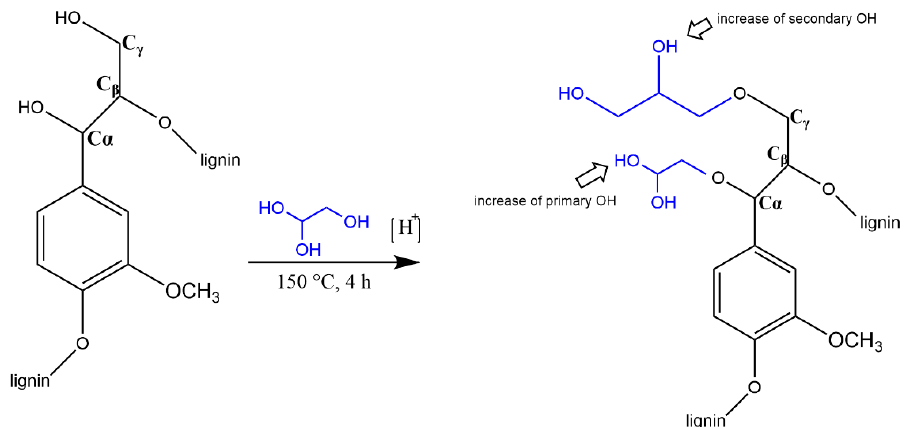
Figure 8. Proposed reaction scheme of lignin with glycerol during wood liquefaction using PTSA ( ρ -toluene sulfonic acid) as a catalyst based on carbon assignments, adapted from [81]. Typically, the product obtained from the liquefaction process is a mixture of liquefied lignin and solid residue, the latter being a limiting factor of the liquefaction yield. To over- come or avoid the formation of residue and recondensation reactions, reaction parameters such as temperature, time, catalyst loading, and lignin/solvent ratio can be optimized.